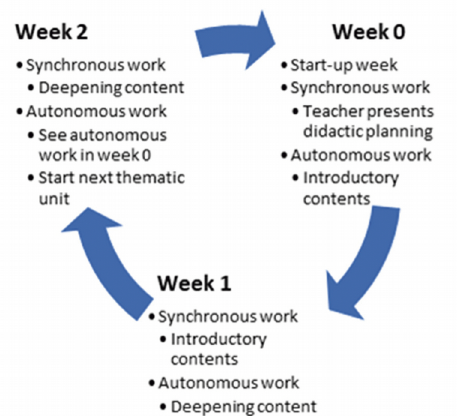
Figure 1. The temporal sequence of autonomous work and synchronous virtual work during the flipped classroom